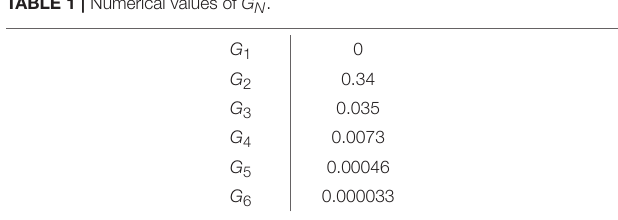
TABLE 1 | Numerical values of G N .